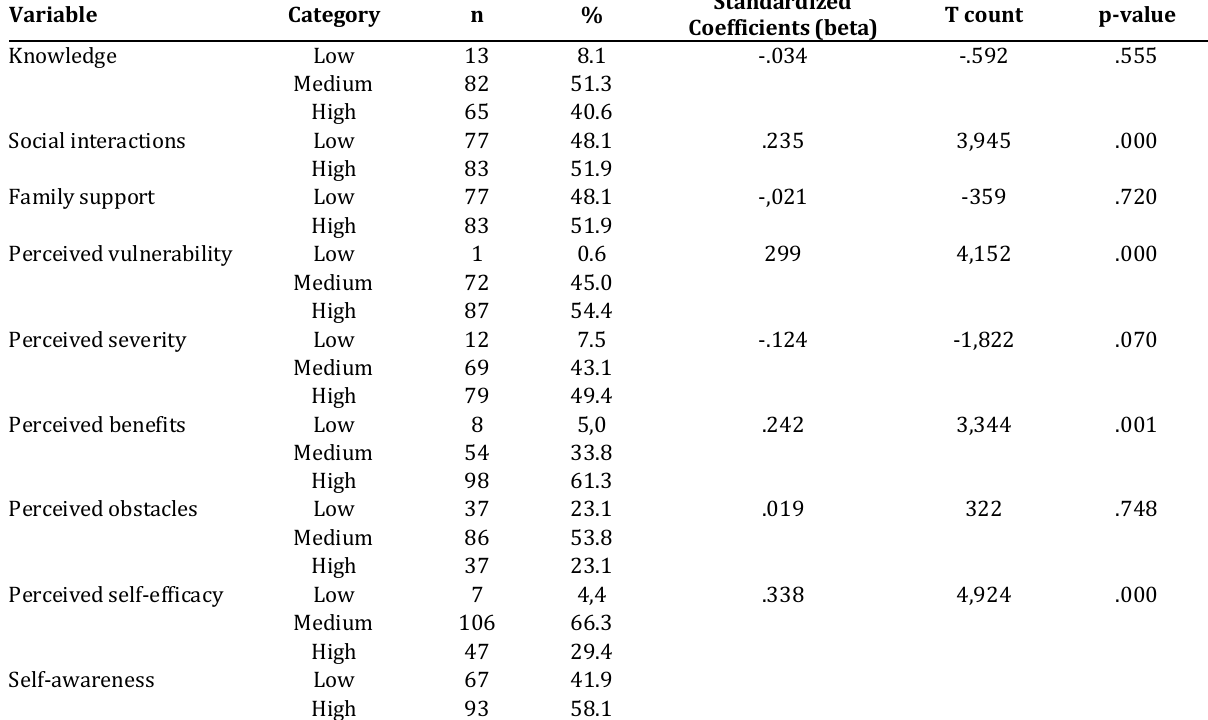
Table 2. Factors related to Students’ Self-Awareness in Conducting Psychosocial Problems Screening Variable Category